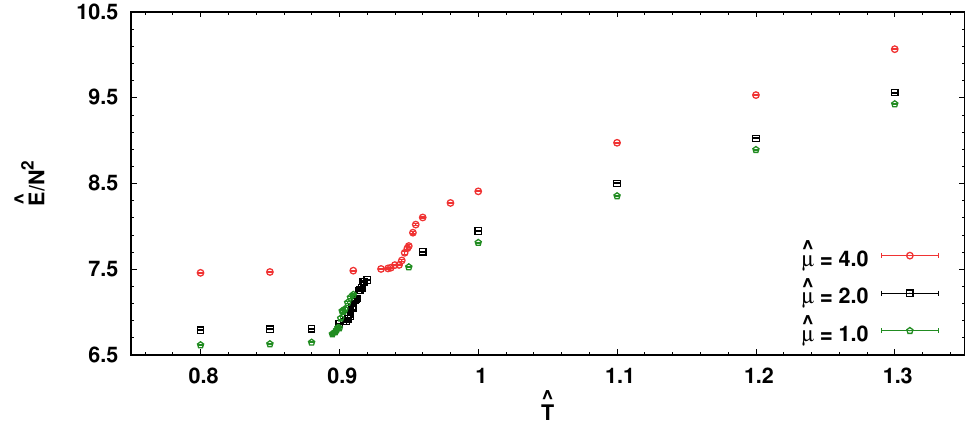
Figure 8. Internal energy vs. temperature for various the energy has no temperature dependence, and after transition it depends linearly on